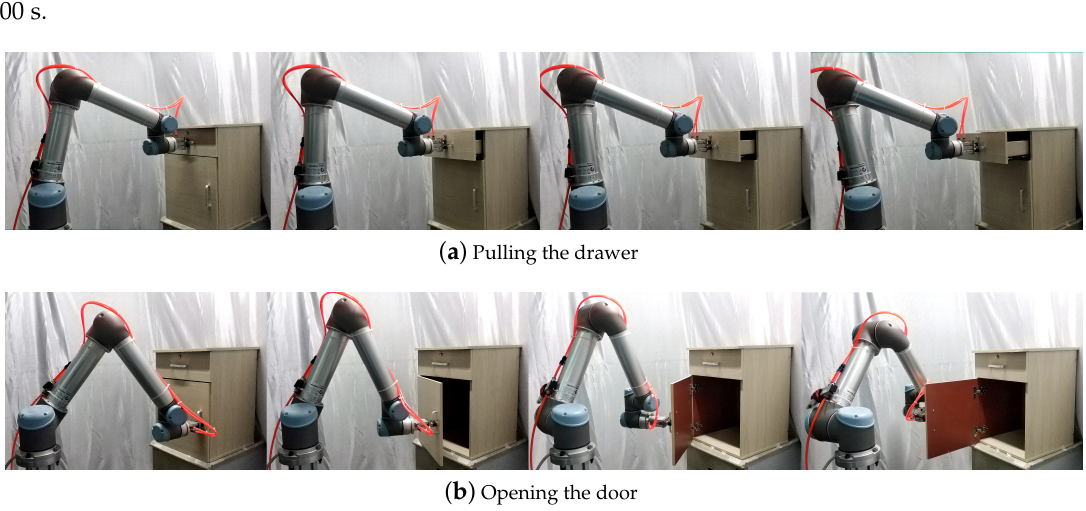
Figure 7. Snapshots of the robot performing constrained manipulation on passive